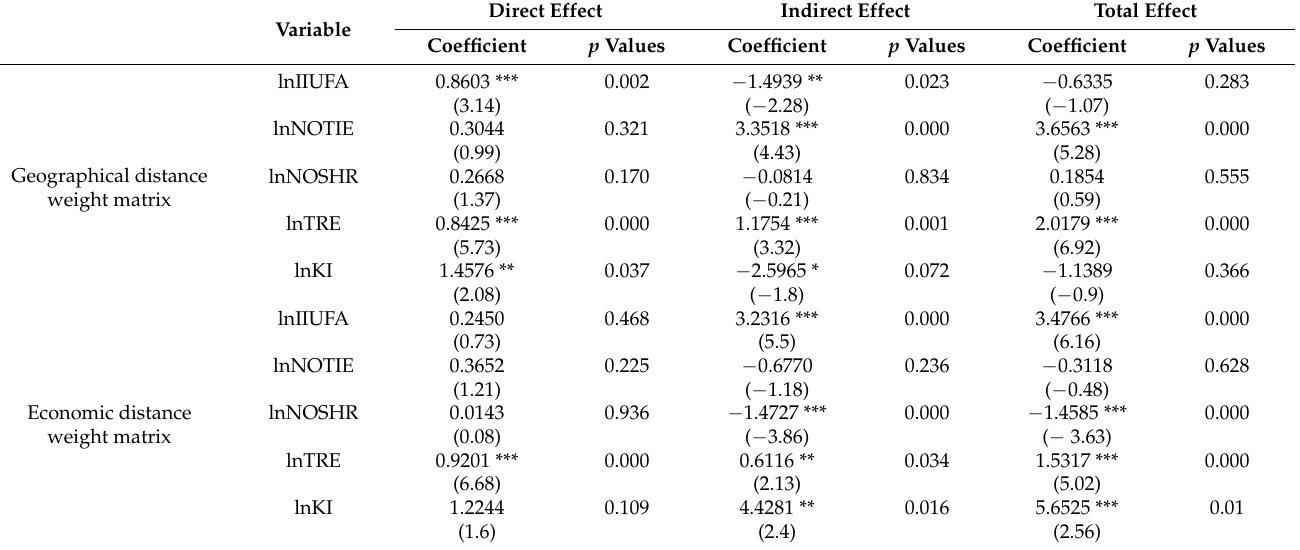
Table 5. Partial differential estimation results of spatial spillover